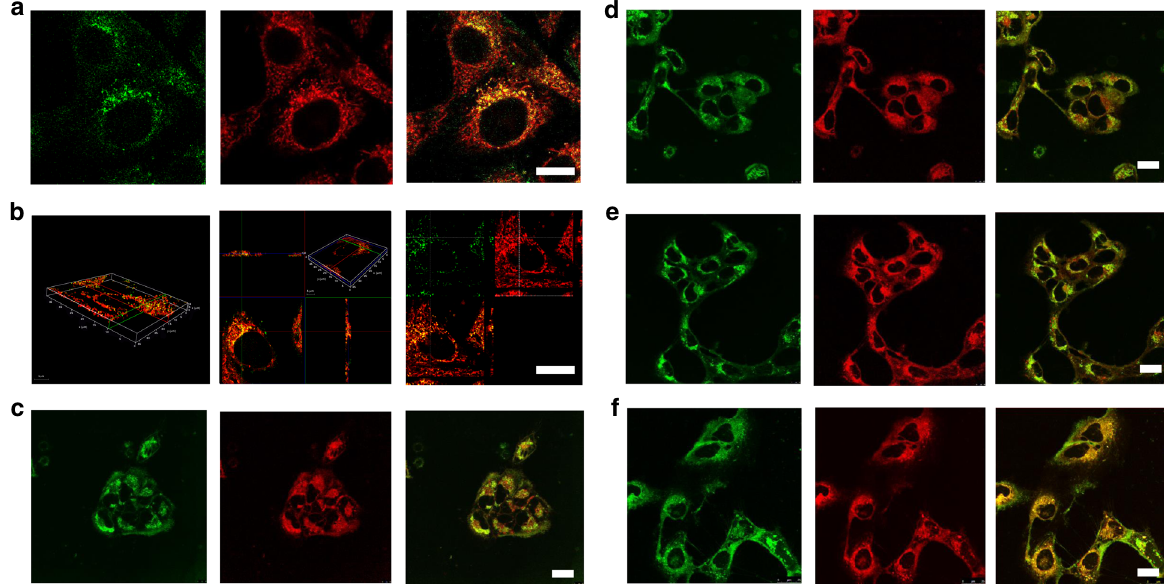
Fig. 6 Mitochondrial localization. a Fluorescent images of 143B cells incubated with 3j-PEG (10 μ M) for 8 h (left); with Mito-tracker red (middle) and merge images of them (right). λ em : 590 – 650 nm, λ ex : 594 nm (Mito-tracker red); λ em : 490 – 540 nm, λ ex : 488 nm (3j-PEG). b Merge images of 3j-PEG and Mito-tracker red in 3D fl uorescence images of mitochondrial localization. c – e Fluorescent images of 143B cells incubated with Mito-tracker green (left), with c 3k-PEG (1 μ M) or d H4-PEG (1 μ M), or e H4-PEG-PT (1 μ M) for 6 h (middle) and merge images them (right), respectively. λ em : 495 – 526 nm, λ ex : 488 nm (Mito-tracker green); λ em : 610 – 660 nm, λ ex : 514 nm (3k-PEG, H4-PEG, and H4-PEG-PT). f Fluorescent images of 143B cells incubated with Mitochondria-GFP (left), H4-PEG-PT (middle), and merge images of them (right). λ em : 495 – 526 nm, λ ex : 488 nm (Mitochondria-GFP); λ em : 610 – 660 nm, μ m. Results in ( a – f ) are representative of three independent λ ex : 514 nm (H4-PEG-PT). Scale bar: 10